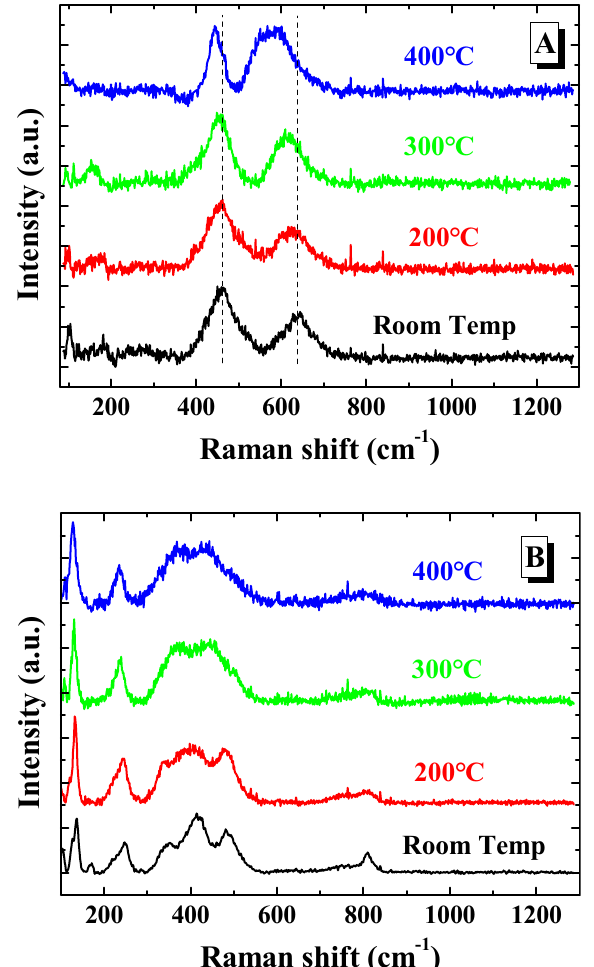
Figure 2. Raman spectra of ( A ) U 3 O 7 and ( B ) U 3 O 8 under inert conditions (Ar) as a function of temperature in the region studied in this